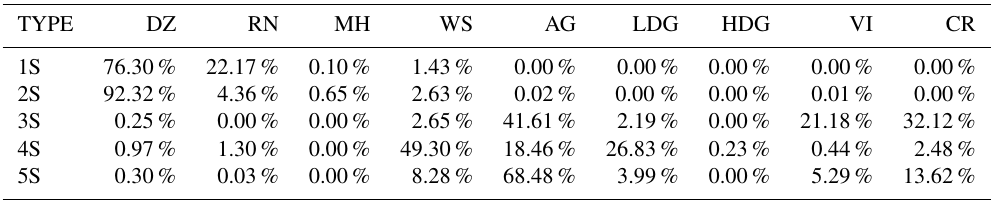
Figure 10. Same as Fig. 7, but for the stratiform regime of the dry season (DZ is drizzle, RN is rain, WS is wet snow, AG is aggregates, and IC is ice crystals). Table 5. Same as Table 3, but for the stratiform region of the dry